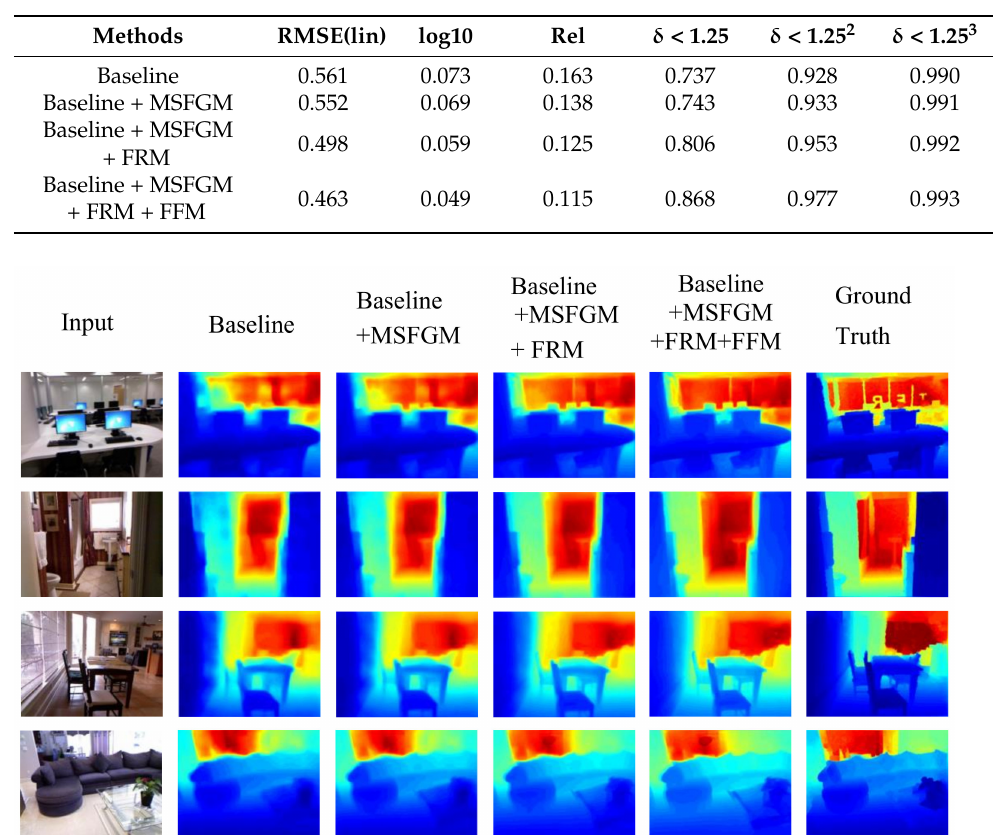
Table 4. Quantitative comparison of MSFGM, FRM, and FFM.